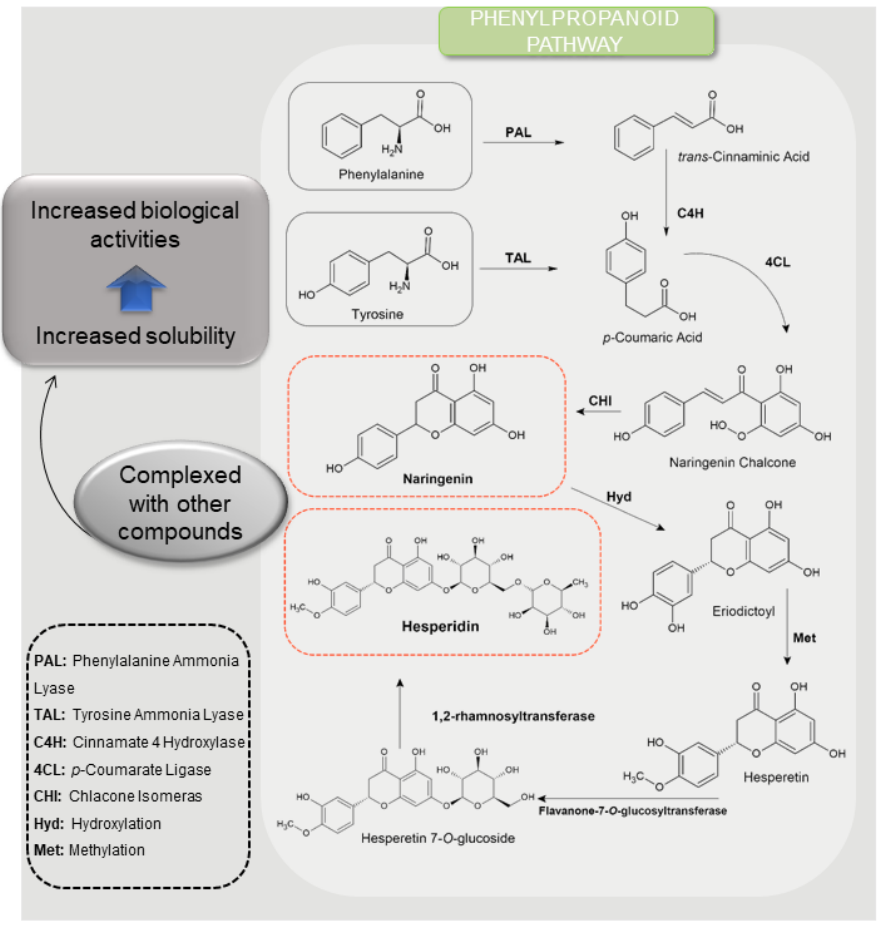
Figure 2. Naringenin and hesperidin follow a common pathway through the phenylpropanoid